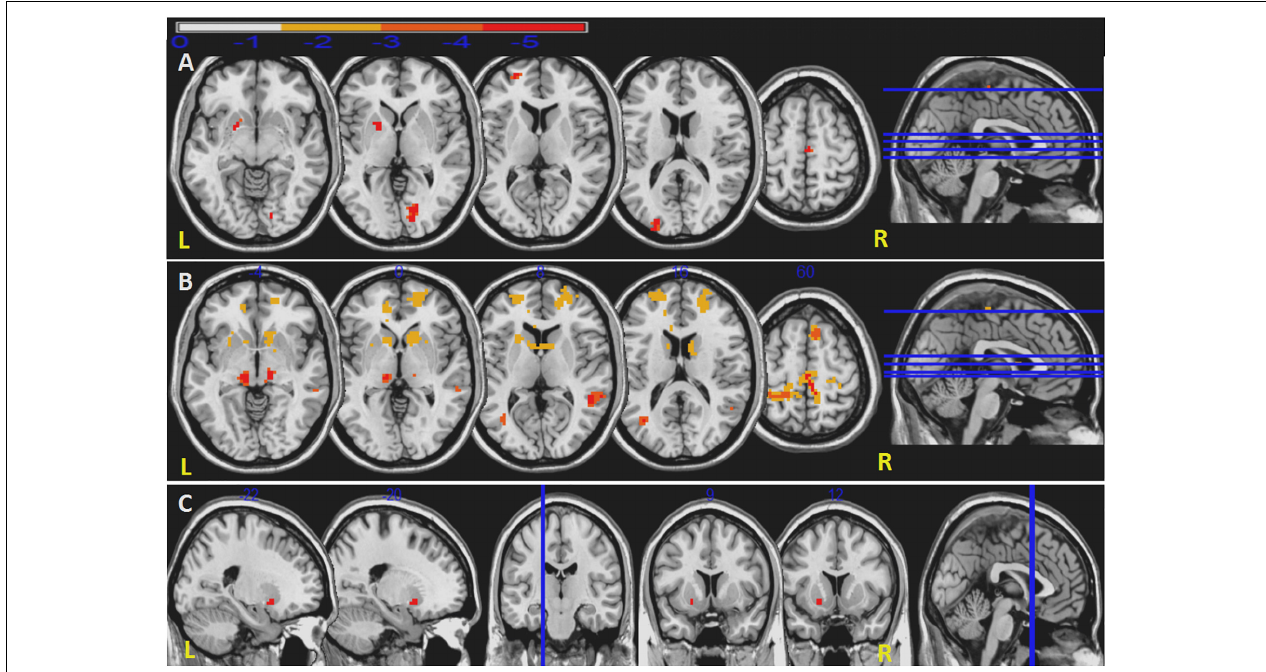
FIGURE 2 | Decreased FCs in iRBD patients. Decreased right caudate-related FCs (A) . Decreased left pallidum-related FCs (B) . Decreased FCs between right putamen and left putamen (C) . Significant level is set at P < 0.05 corrected by TFCE.